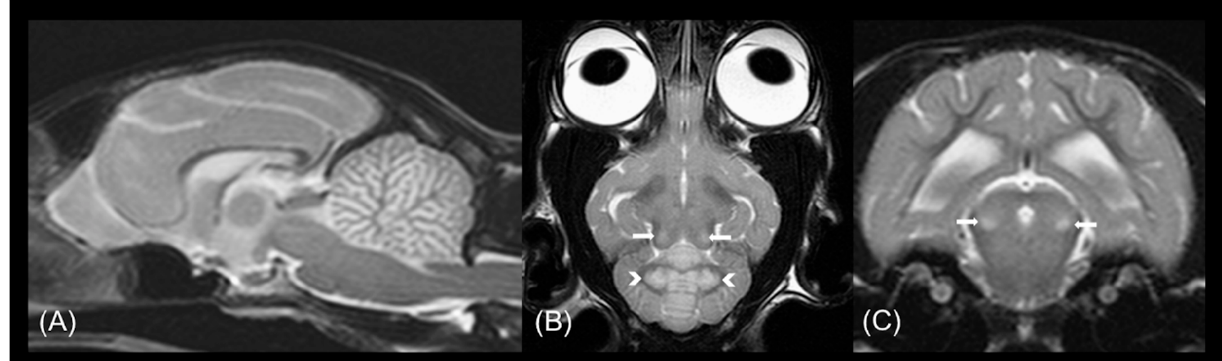
Figure 1. MRI abnormalities in a cat with L2HGA. ( A ) Mid-sagittal T2-weighted, ( B ) dorsal T2-weighted and ( C ) transverse T2-weighted MR images demonstrating symmetrical involvement of predominantly grey matter structures are shown. Consistent bilateral symmetrical T2 hyperintensity of the deep cerebellar nuclei (white arrowheads) and caudal colliculi (white arrows) and diffuse T2-weighted hyperintensity affecting the cerebellar cortex can be seen.